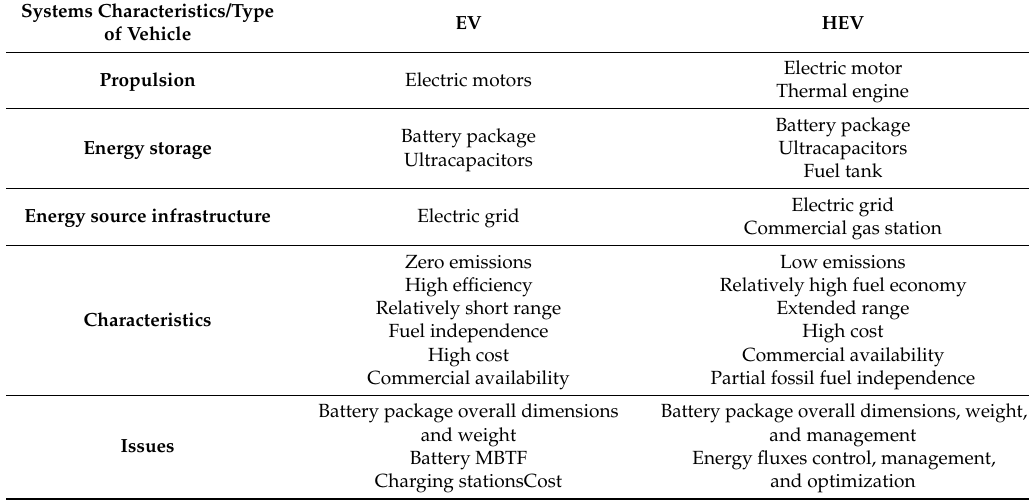
Table 2. Electric Vehicle (EV) and Hybrid Electric Vehicle (HEV) Comparison [2–4].